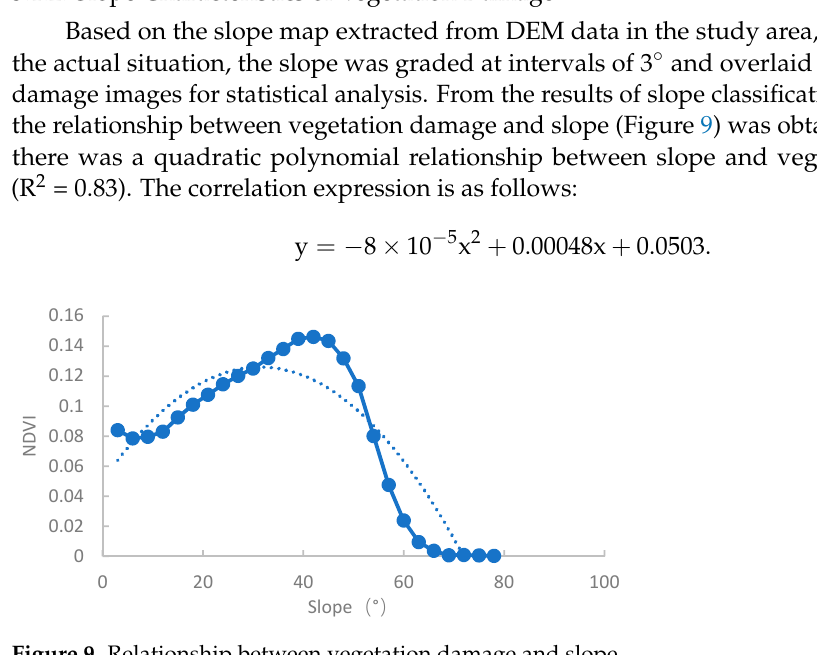
Figure 10. Relationship between vegetation damage and slope orientation. 3.1.4. Characteristics of Vegetation Damage in Areas with Intensive Human Activities Human activities are mainly concentrated in urban residential areas and road areas, where the vegetation is greatly affected by the interference of human activities, and the vegetation is less distributed and relatively fragile. In the urban residential areas and road areas in the study area, multi-level buffer analysis was carried out according to the sepa- ration distance of 1 km, and the vegetation damage map was superimposed for statistical analysis. Then, the statistical data of vegetation damage at different distances from areas